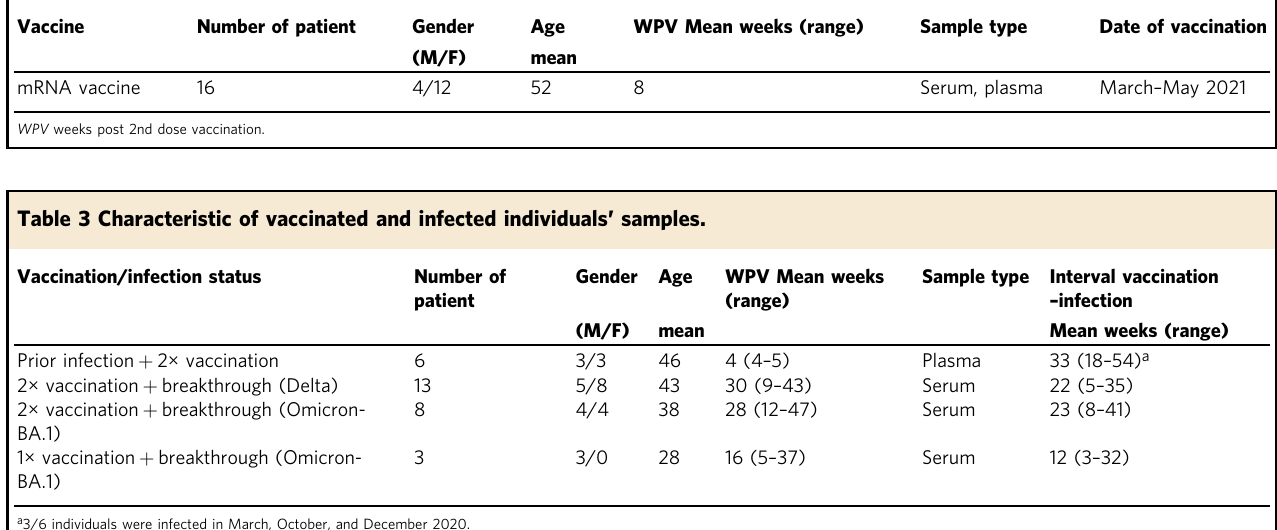
1× vaccination + breakthrough (Omicron- BA.1)